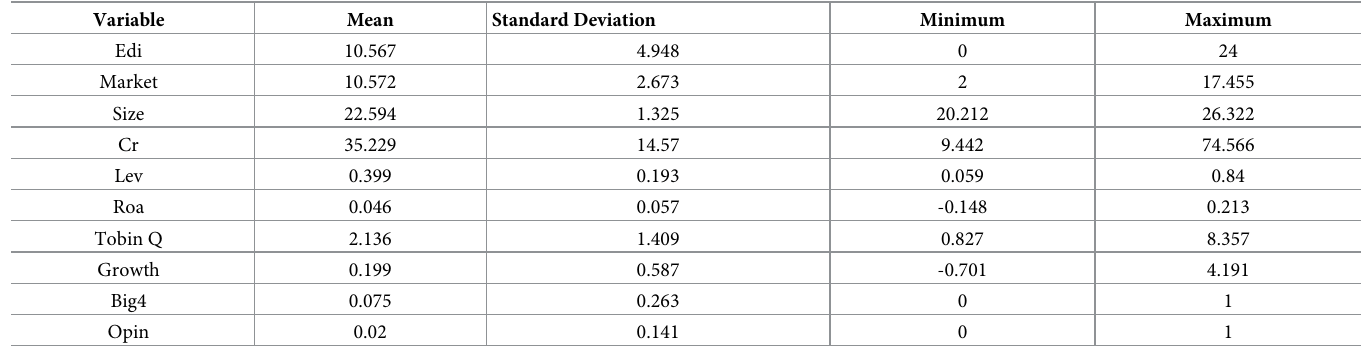
Table 3. Descriptive statistical results of variables.